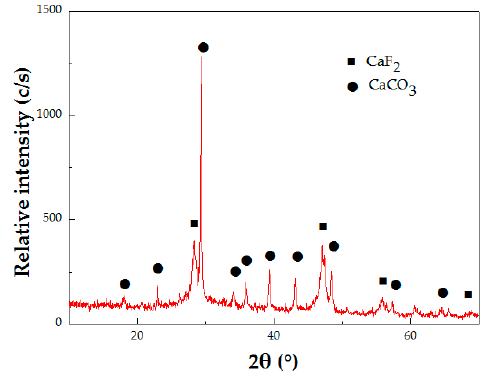
Figure 13. Diffractogram of the solid precipitated by the addition of CaCO 3 .